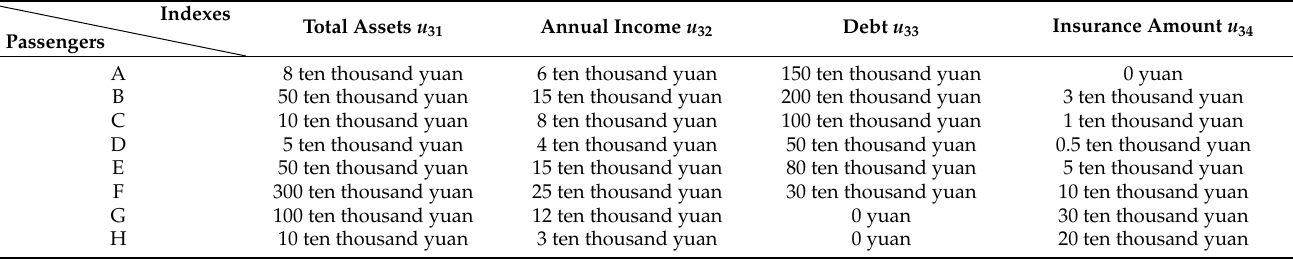
Table 16. Sample data of passengers (economic situation